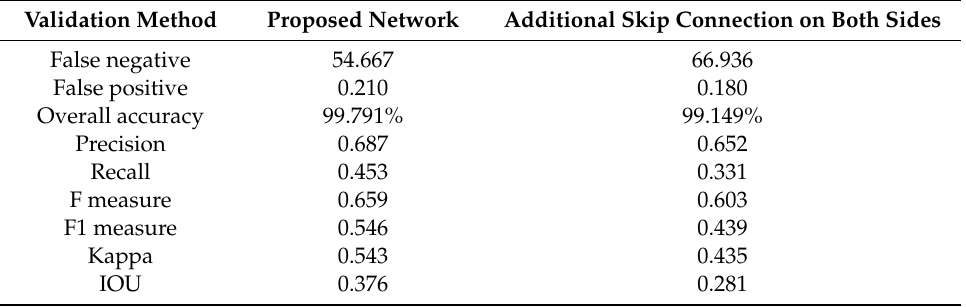
Table 5. Accuracy of the model in the di ff erent skip connections in the architecture at the Bangkok site.